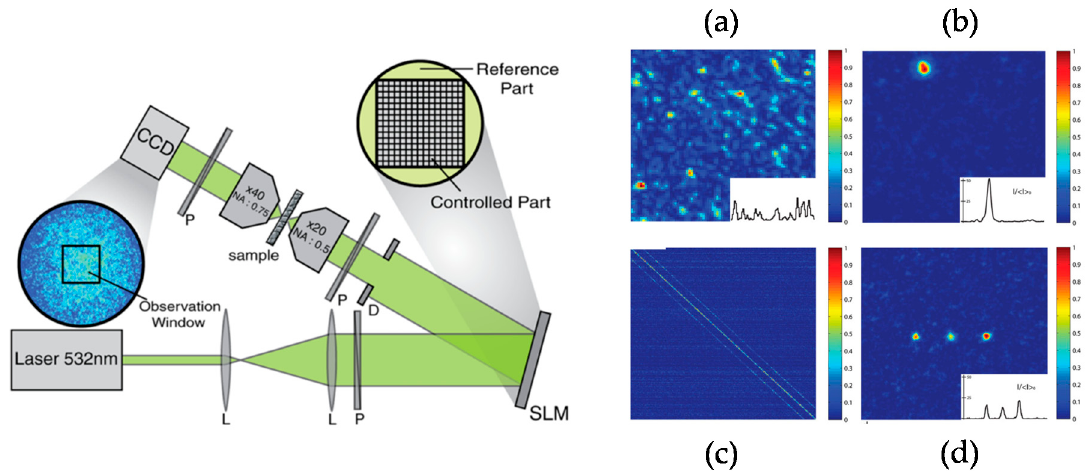
Figure 4. Left: schematic of the experiment. Right: ( a ) the initial optical speckle pattern; ( b ) focusing light onto one focus by measuring the TM with 256 controlled units on the SLM; ( c ) the norm of the focusing operator: each line represents the desired output focusing signal on CCD camera; and ( d ) an example of focusing light onto multiple foci (Figure reproduced from ref. [21]).